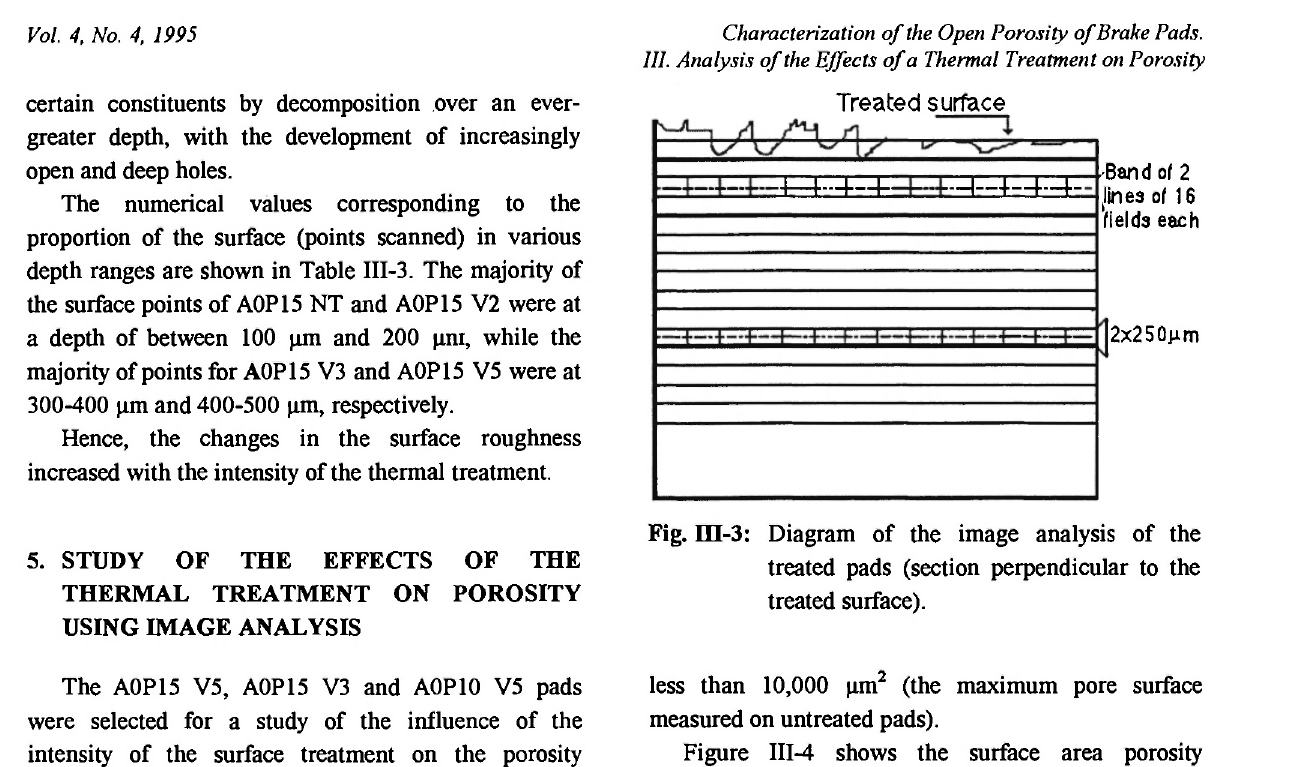
Fig. ΕΠ-3: Diagram of the image analysis of the treated pads (section perpendicular to the treated surface).